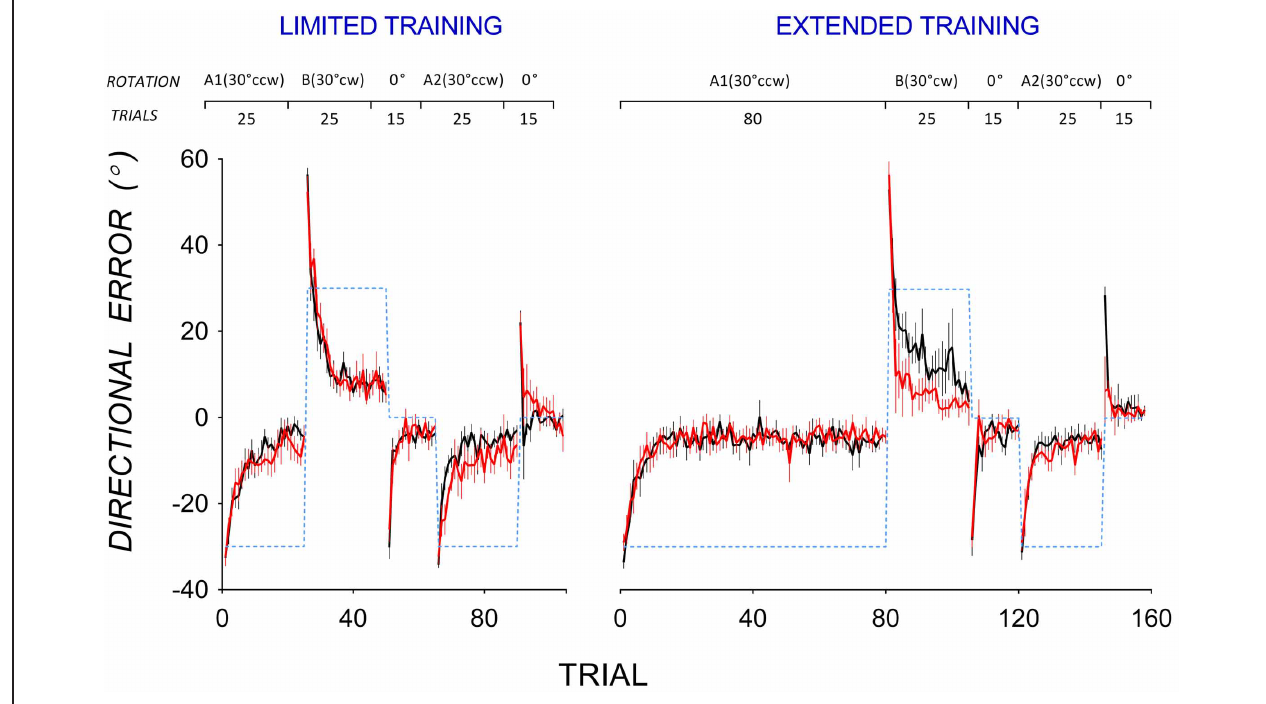
FIGURE 1 | Mean trial-by-trial directional error during the adaptation phase for the limited training (top) and extended training (bottom) conditions in PD patients (black lines) and controls (red lines). Error bars